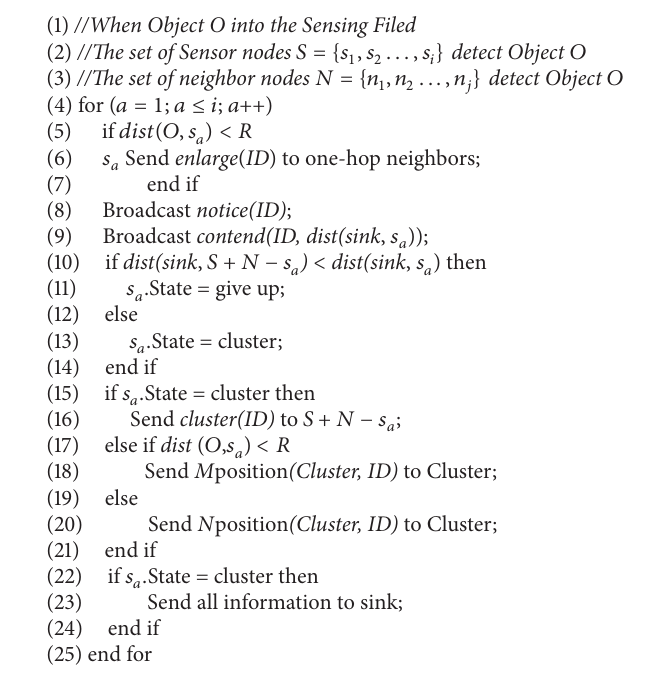
Algorithm 2: Algorithm of the proposed location estimation